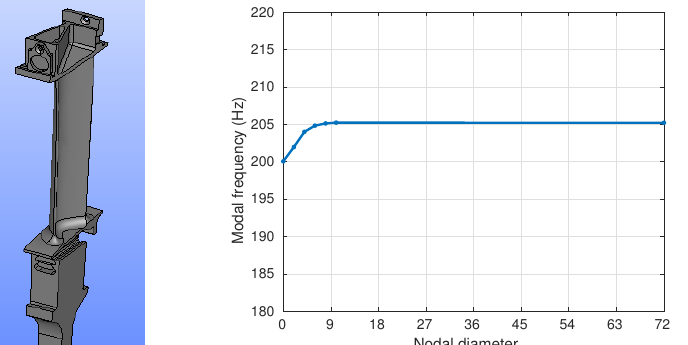
Figure 1. FEM model of the LPT rotor sector ( left ), and vibration frequencies of the first modal family ( right ) for the tuned configuration.